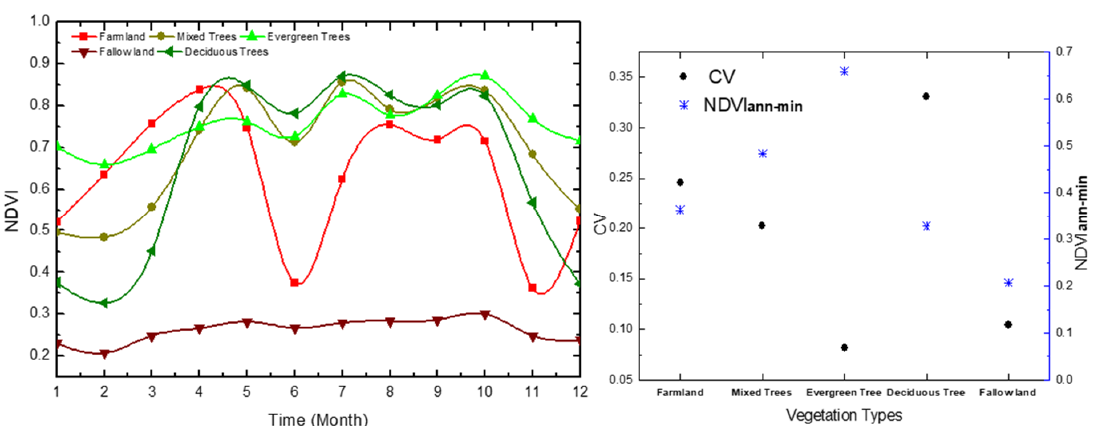
Figure 3. Different vegetation pixels of the time-series variation of Landsat 8-derived normalized difference vegetation index (NDVI) curves (left), and the coefficient of variation (CV) value and annual minimum NDVI (NDVI ann-min ) value corresponding to each curve (right).